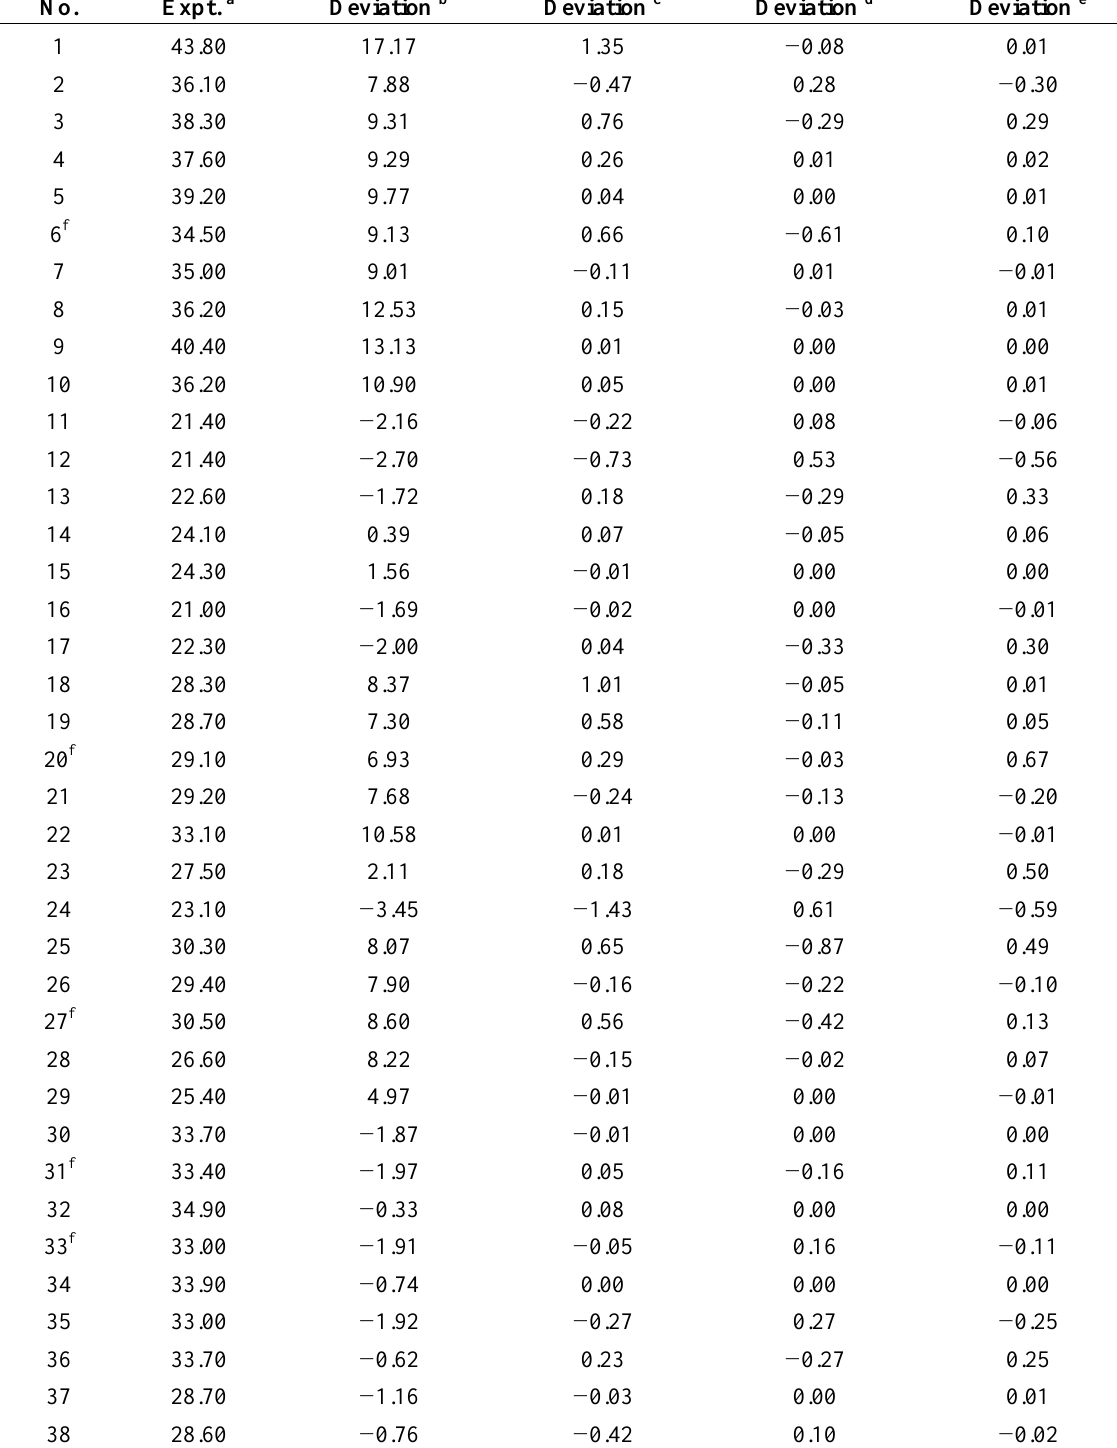
experimental and calculated values of 92 organic molecules (in kcal mol − 1